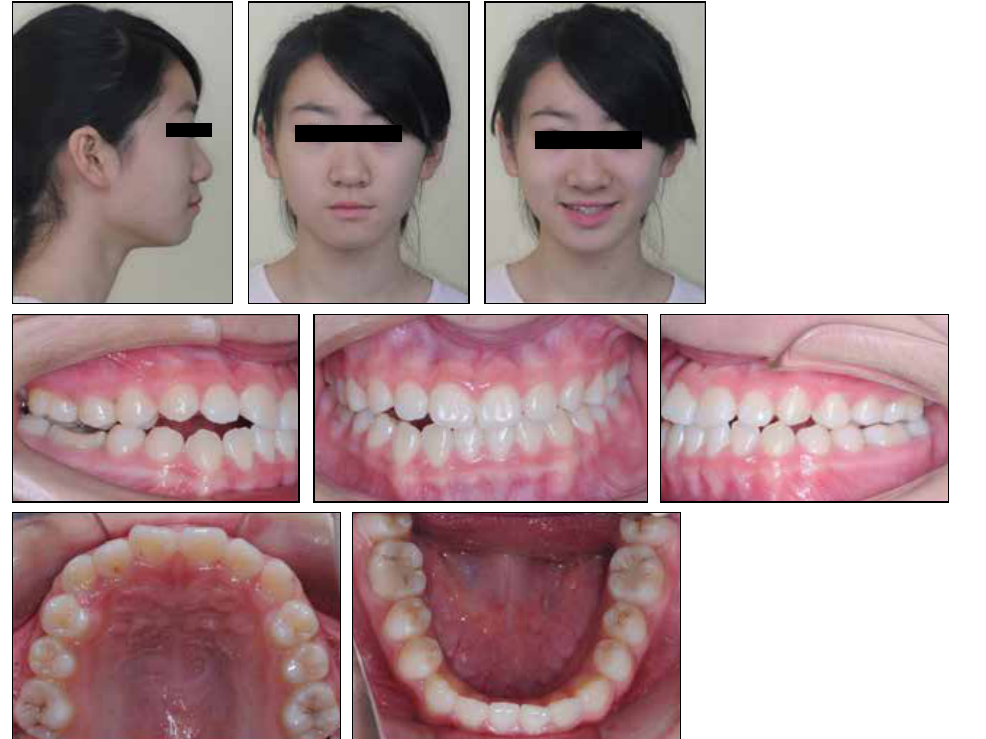
Figure 6. The facial and intraoral photographs after the first phase of treatment.